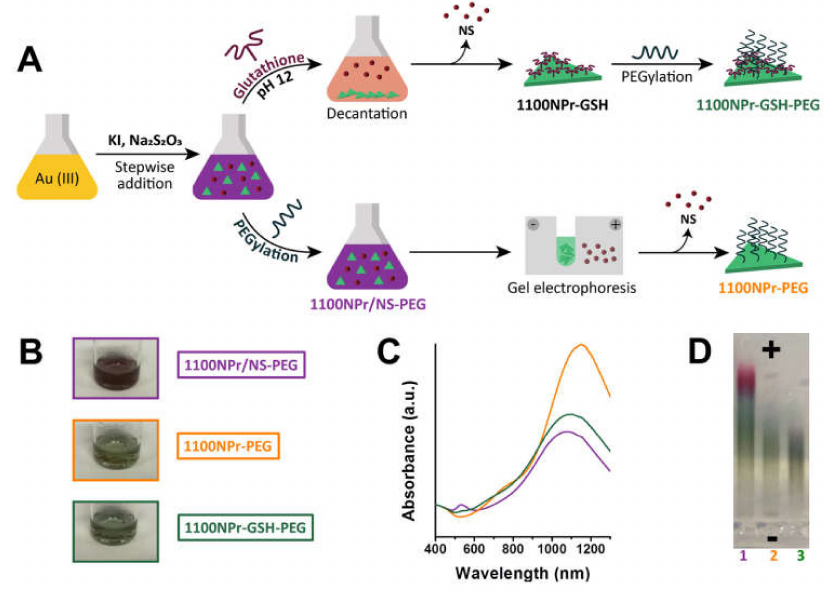
Figure 2. ( A ) Synthesis and purification of gold NPrs using two approaches: GSH-mediated deposition and electrophoresis separation. ( B ) Appearance of the NPr preparations. ( C ) UV-Vis-NIR absorption spectra and images of the NPr preparations for NPrs with LS PR band at ca. 1100 nm. ( D ) Electrophoresis gel comparison of the NP content between the three samples. Color code: 1100NPr / NS-PEG ( — ), 1100NPr-GSH-PEG ( — ), 1100NPr-PEG ( — ).